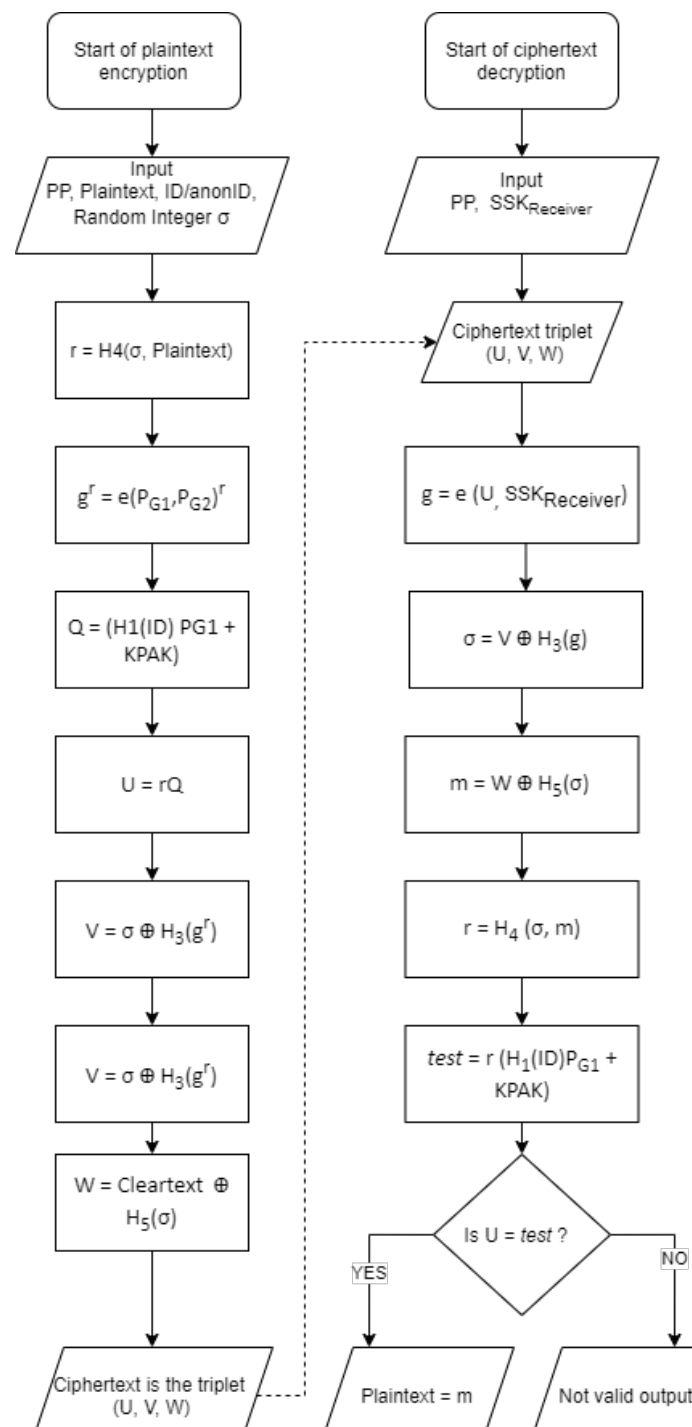
Figure 4. ARIBC encryption and decryption